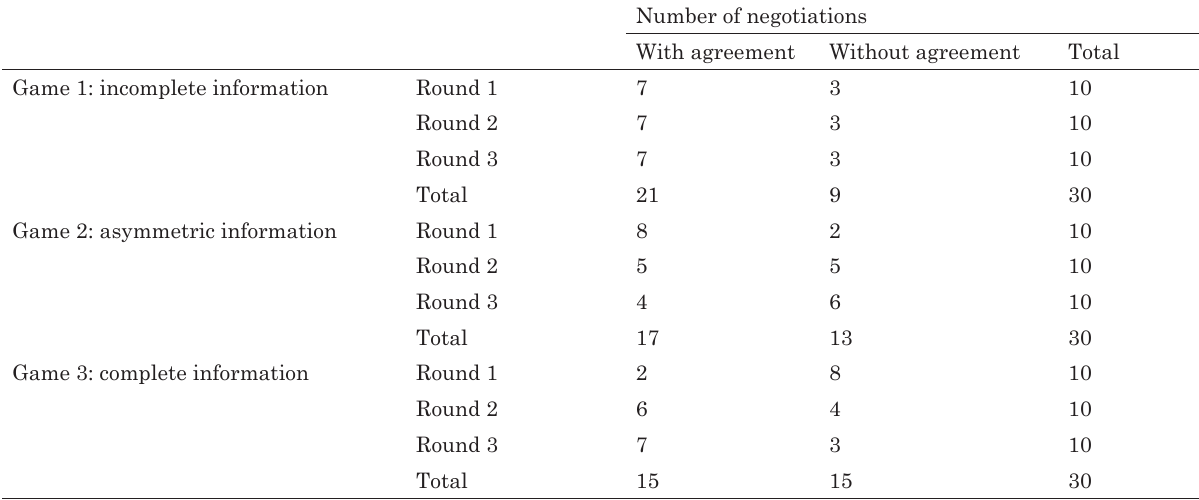
Table 2. Number of negotiations with and without agreements